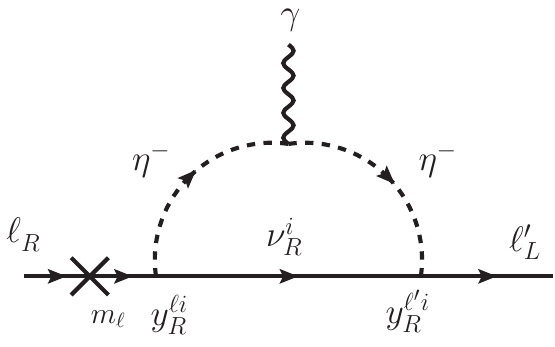
Figure 3 . Feynman diagrams for LFV decays of charged leptons with ‘ 6 = ‘ 0